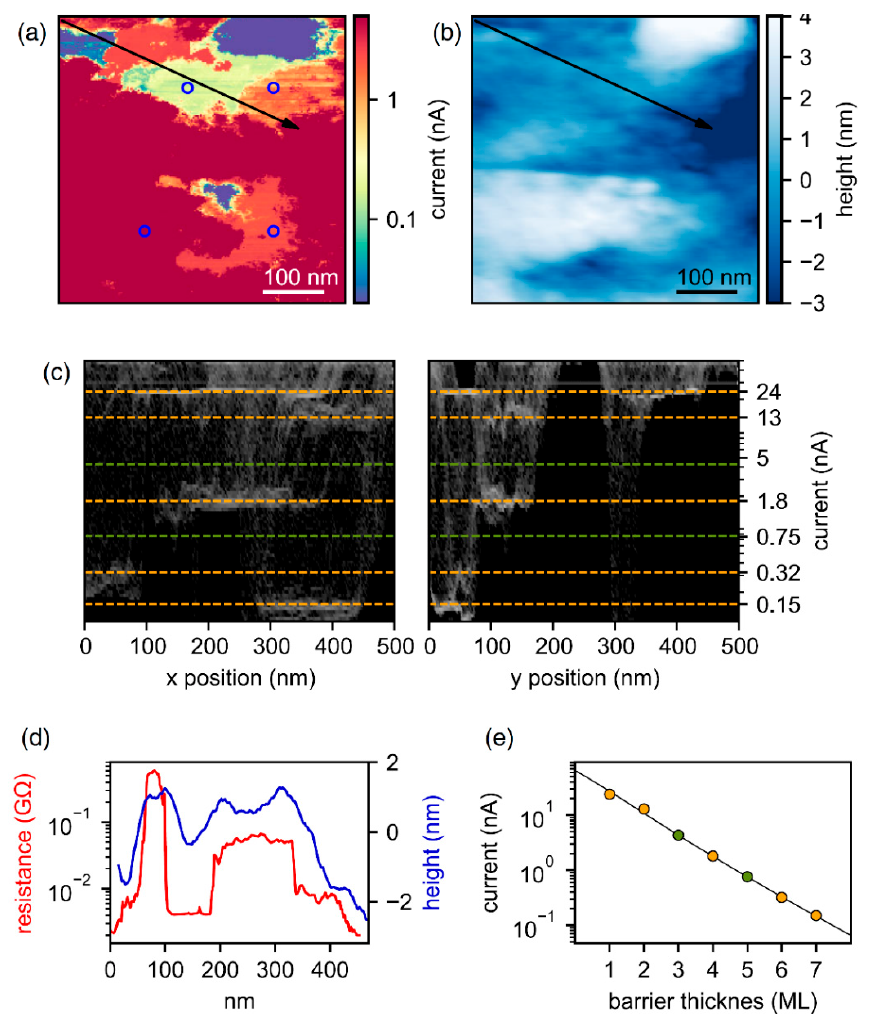
Figure 10. ( a ) A current map recorded at U = 0.1 V after switching to the low resistive state (LRS) (red). Negative voltage pulses have been applied at the locations indicated by circles; ( b ) Corresponding topography image. The correlation between contact resistance (red) and height (blue) is illustrated by profiles along the indicated path ( d ); ( c ) Distribution of current values depending on the “x” and “y” locations as an intensity map. The identified logarithmically spaced current values are shown in orange (missing levels are indicated in green); and ( e ) Current as a function of the tunnel barrier thickness with a fit curve according to the Metal–Insulator–Metal model. “Reprinted figure with permission from [35] Copyright (2019) by the American Physical